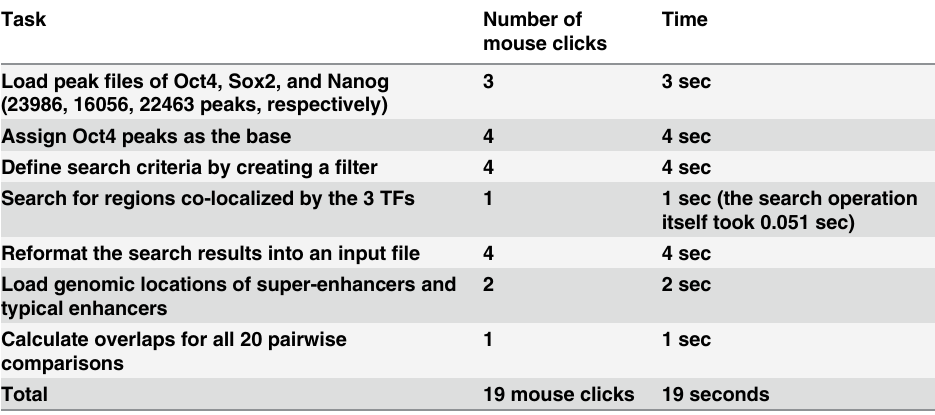
Time mouse clicks 3 3 sec itself took 0.051 sec) 2 2 sec 1 1 sec